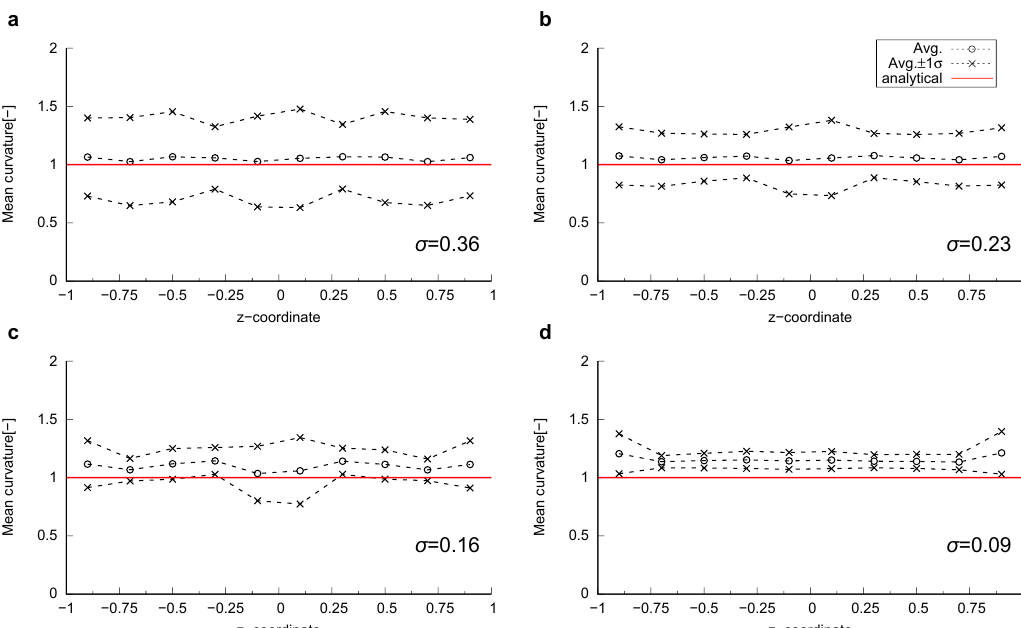
Figure 4. The computed mean curvatures together with the values plus and minus one standard deviation ( σ ) on the smoothed surfaces of the sphere compared to the analytical value as a function of the z -coordinate. The mean curvature of the sphere for ( a ) ∆ = 0.025, ( b ) ∆ = 0.05, ( c ) ∆ = 0.1 and ( d ) ∆ = 0.2.